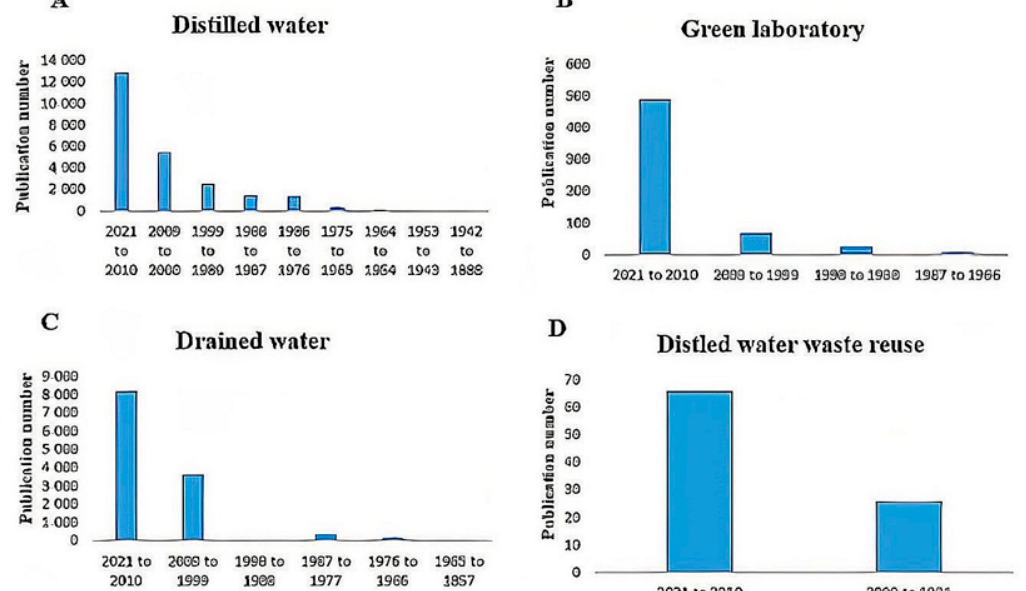
Figure 1. Number of published articles via PubMed engine using the keywords of ( A ): Distilled water; ( B ): Green laboratory; ( C ): Drained water; ( D ): Distilled water waste re-use (23 May 2021).